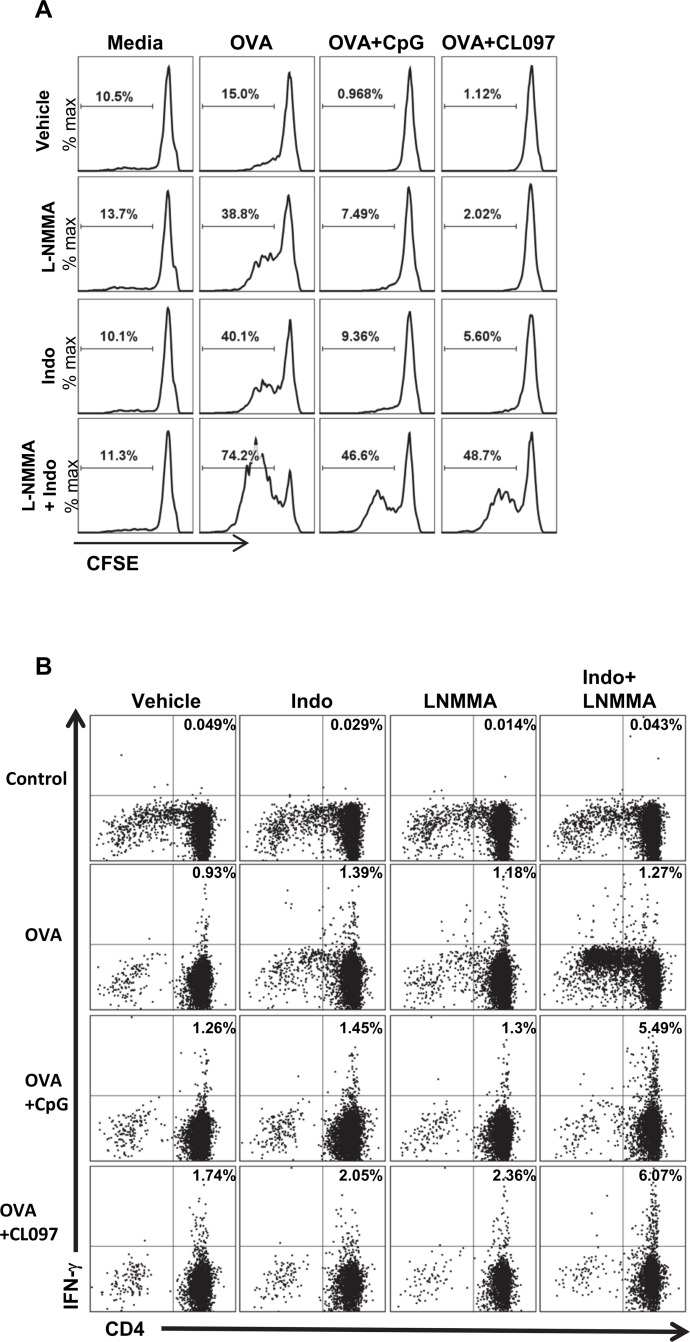
Inhibition of COX-1/COX-2 and iNOS synergistically enhances OT-II CD4+ T cell proliferation and IFN-γ production in vitro.(A) CFSE-stained OT-II CD4+ T cells were mixed with congenic DCs and stimulated with OVA protein with or without TLR agonists in combination with L-NMMA (40 μM) or Indo (10 μM) for 4 days. Proliferation of OT-II CD4+ T cells were analyzed by CFSE dilution. The range and number in each plot indicate cells that proliferated at least one time. Data shown are representative of two independent experiments. (B) OT-II CD4+ T cells were mixed with congenic DCs and stimulated with OVA protein with or without TLR agonists and inhibitors for 4 days. GolgiPlug was added to the cultures to inhibit exocytosis of intracellular IFN-γ at 5 h before harvest. Cells were first stained for CD4, fixed, and stained for intracellular IFN-γ. The numbers in the upper right quadrant signifies the percentage of IFN-γ positive cells among CD4+ T cells. Dead cells were excluded using a fixable live/dead dye. Data shown are representative of two independent experiments. iNOS: inducible nitric oxide synthase; COX: cyclooxygenase.